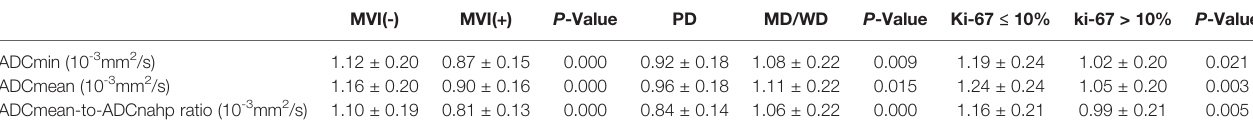
TABLE 2 | ADC value and pathological features of hepatocellular carcinoma. MVI(-) MVI(+) P -Value PD